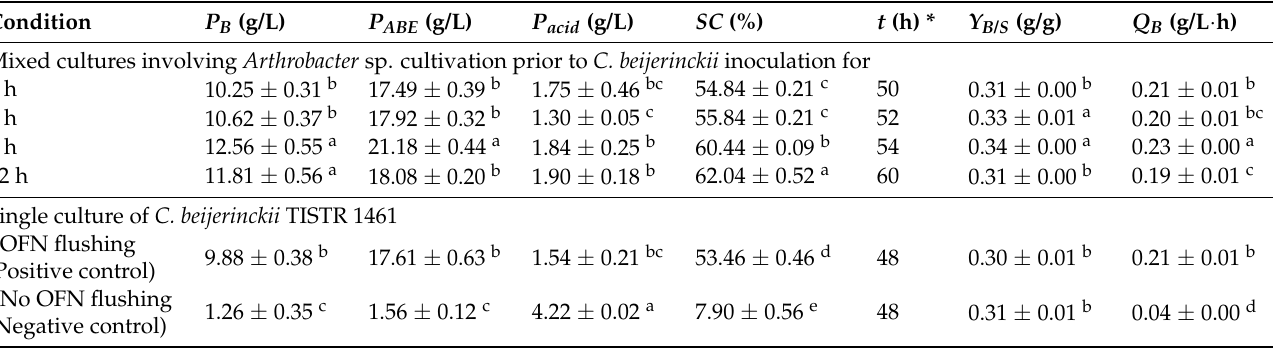
Figure 2. Profiles of pH ( a ), butanol ( b ), ABE ( c ) and sugar ( d ) concentrations during ABE fermen- tation by the mixed cultures and single culture (positive control ( □ ); negative control ( ○ )). In the mixed cultures, C. beijerinckii TISTR 1461 was inoculated after 2 ( ◇ ), 4 ( △ ), 6 ( ▽ ) and 12 h ( ☆ ) of Arthrobacter sp. cultivation. Table 1. Kinetic parameters of ABE fermentation by the mixed cultures of C. beijerinckii TISTR